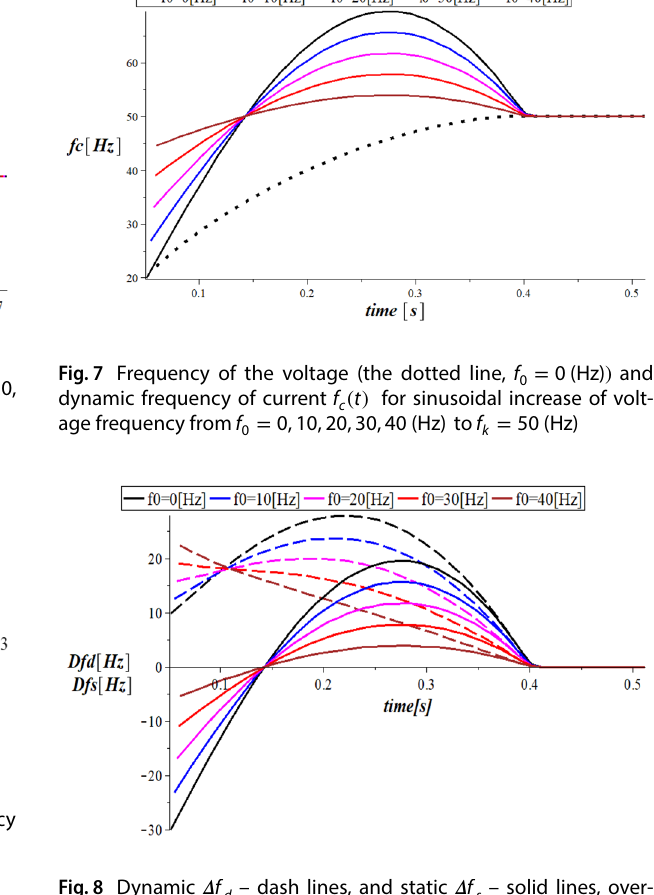
Fig. 8 Dynamic 𝛥 f d – dash lines, and static 𝛥 f s – solid lines, over- shoot of frequency of current, for sinusoidal increase of voltage fre- quency from f 0 = 0,10,20,30,40 (Hz) to f k = 50